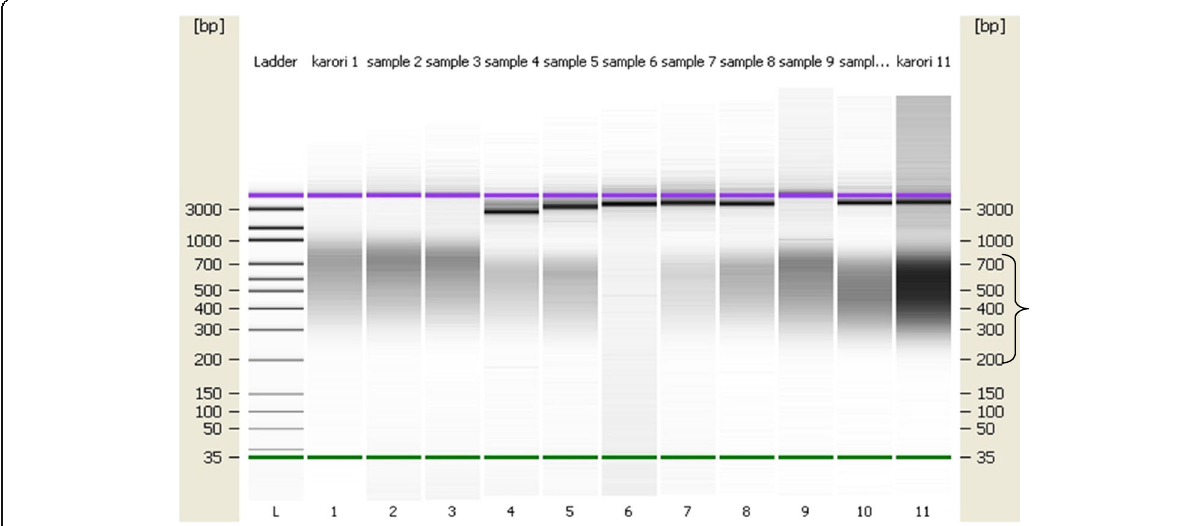
Fig. 8 Gel-like image of the cDNA library samples as run on an Agilent bioanalyzer high sensitivity DNA chip. The samples produced a smear that ranged from 0.2 kb to 7 kb as shown in the arrow